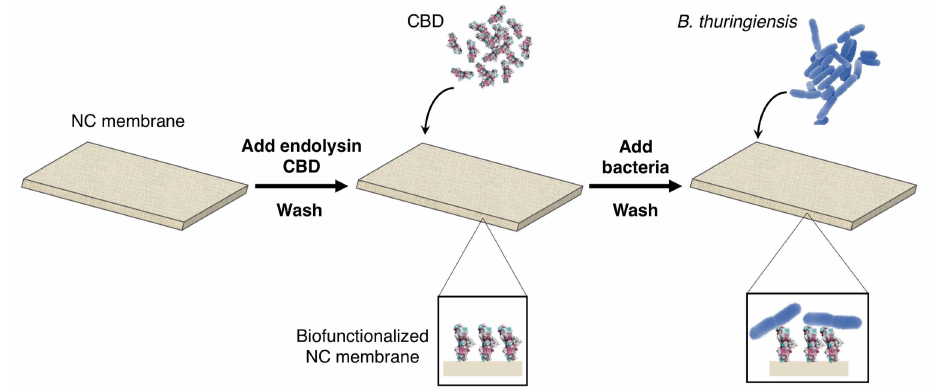
Figure 1. Protocol of the nitrocellulose (NC) membrane biofunctionalization with endolysin cell-wall binding domain (CBD) and validation of the biointerface through capture of B. thuringiensis